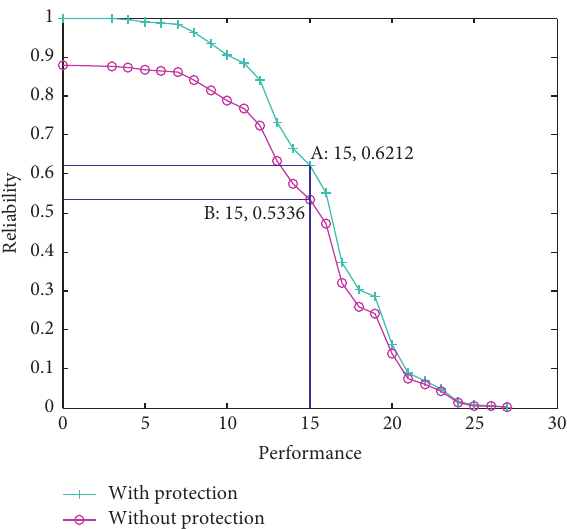
Figure 8: Comparison of reliability of system with and without